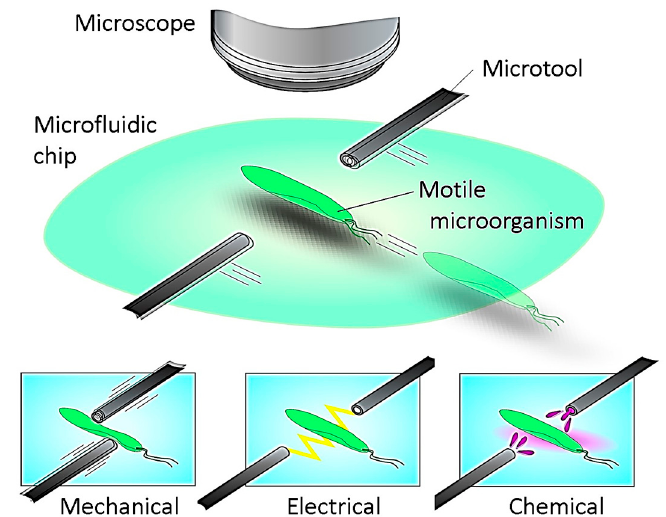
Figure 1. Conceptual image of proposed microrobotic platform. Motile microorganisms are inserted into a microfluidic chip and continuously tracked by a microscope equipped with a high-speed online vision sensor for a long time. External stimulus is then locally applied by using microtools to investigate the stimulus response characteristics of a single motile microorganism.